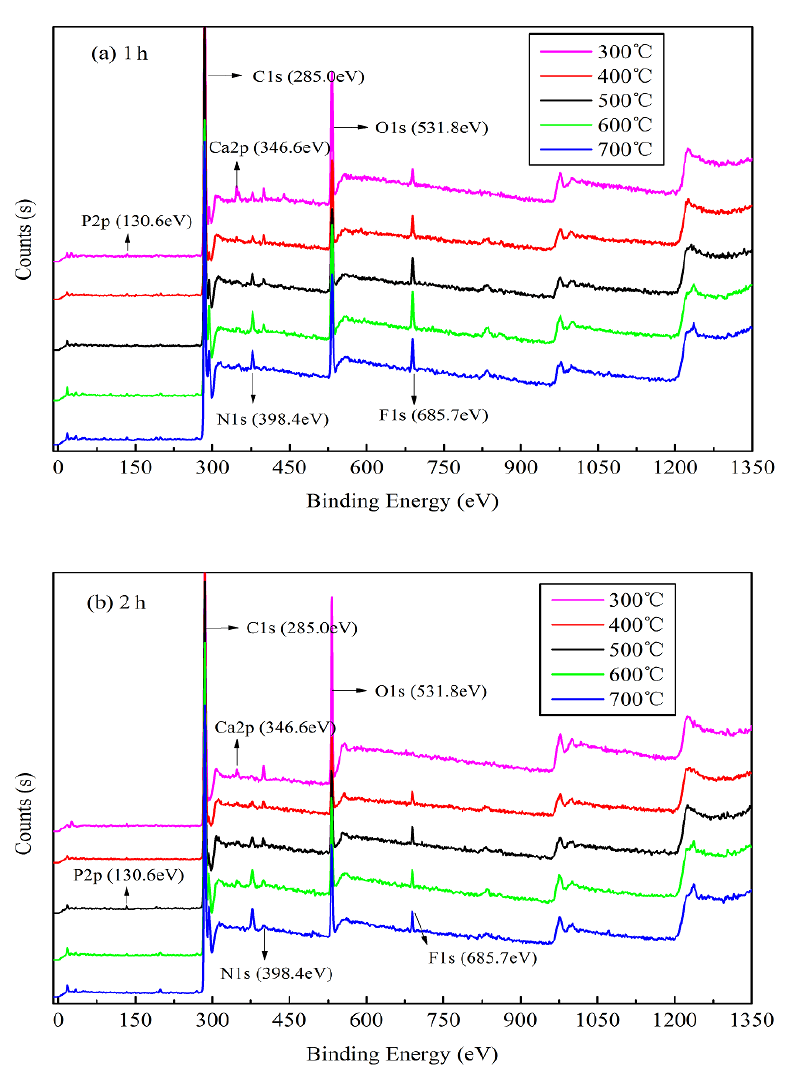
Figure 3. X-ray photoelectron spectra of JB at different carbonization conditions. ( a ) for 1 h; ( b ) for 2 h.